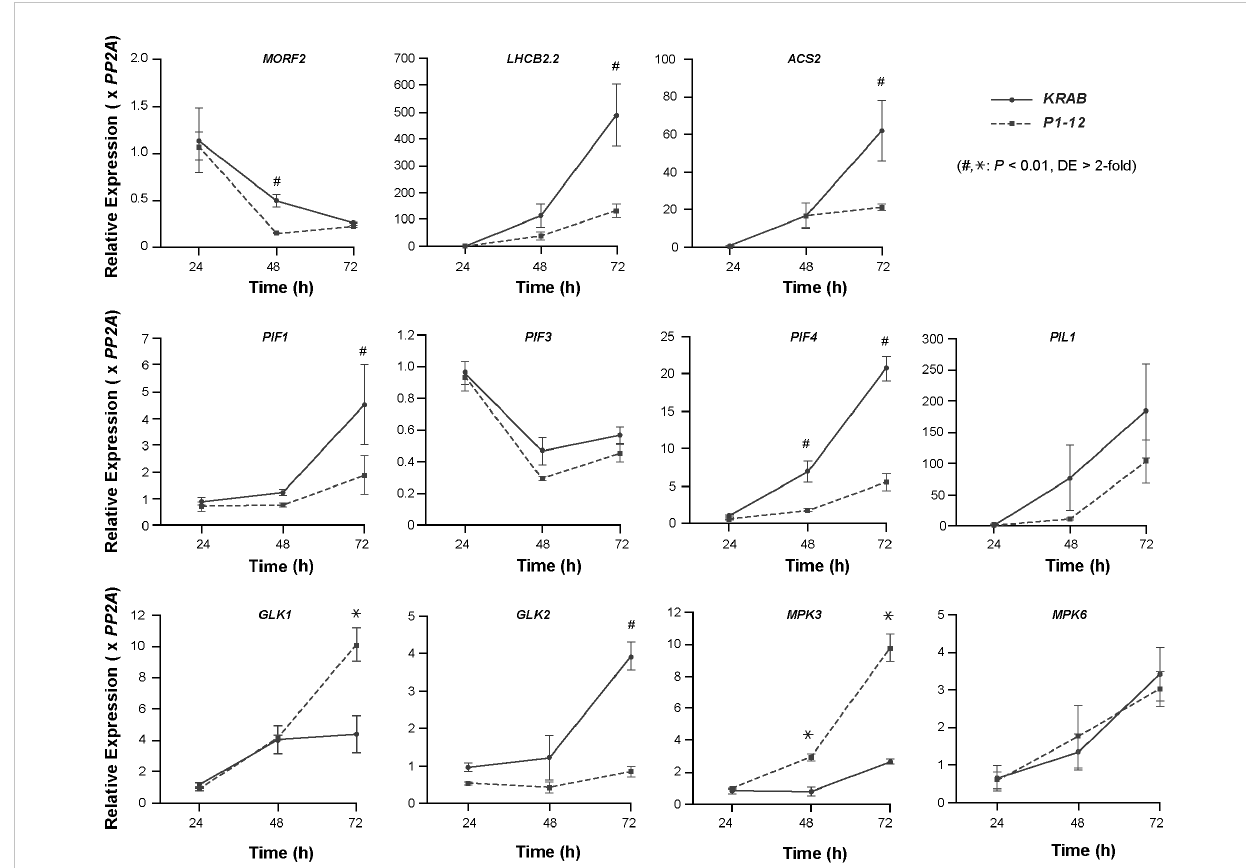
FIGURE 7 Early RS induced by MORF2 reduction suppresses PIFs but activates GLK1 and MPK3 expression. Upon strati fi cation on 1/2 MS medium supplemented with 0.25 m M Dex in dark at 4°C for three days, KRAB and P1-12 seeds were light-treated for 6 hours followed by germination in dark for 24, 48, and 72 h. Either ruptured seeds (24 h) or etiolated seedlings with seed coat (48 h and 72 h) were harvested for qPCR analysis. Relative expression of each indicated gene was normalized to one of the three KRAB biological replicates at 24 h post germination. PP2A was used as reference standards. Each data point represents mean ( ± SD) from three biological replicates, each with three technical replicates. # and * represent a statistically signi fi cant reduction and upregulation, respectively, of indicated gene in P1-12 compared to KRAB (Student ’ s t -test, P < 0.01 and differential expression (DE) changes >